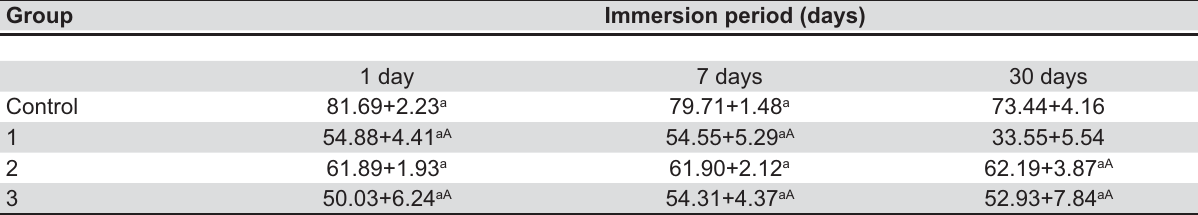
Horizontally, means designated with the same superscripts were not statistically different between periods of immersion (p>0.05)